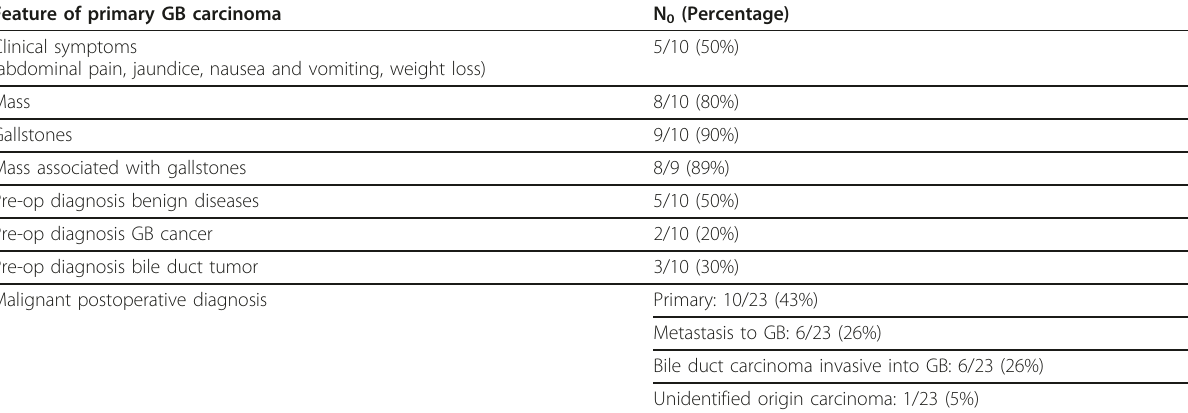
Table 1 Clinical and pathologic features of patients with gallbladder malignancies Feature of primary GB carcinoma Clinical symptoms (abdominal pain, jaundice, nausea and vomiting, weight